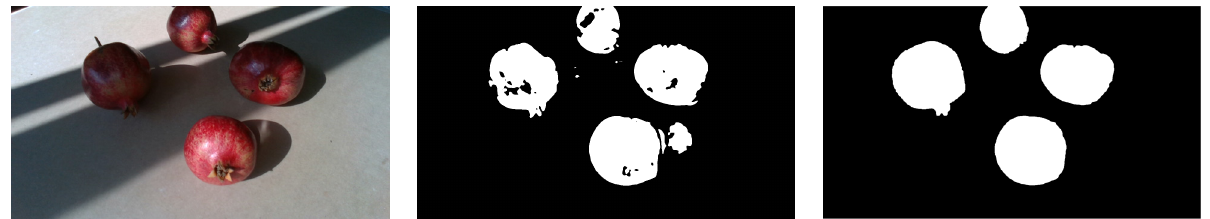
Figure 8. Results of labeling for a sample image of SET2: original image ( left ); labeled image obtained using the First CE net before ( center ) andafter morphological operations ( right ).